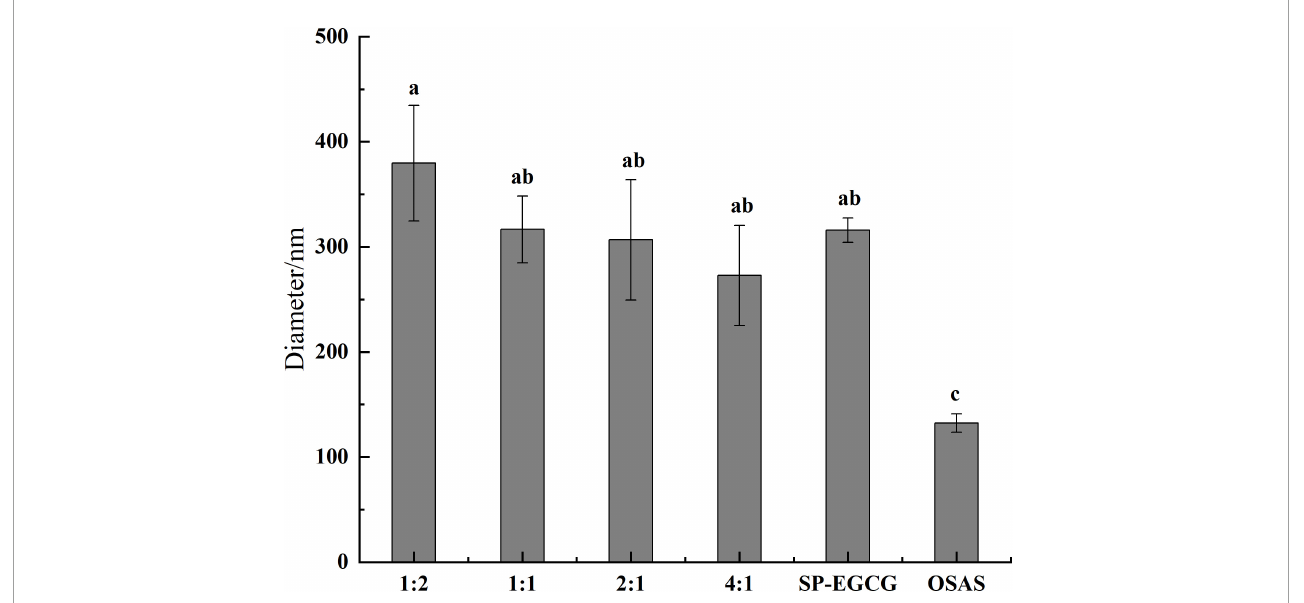
FIGURE1 The average diameters for OSAS-SP-EGCG complexes, SP-EGCG complexes and OSAS.